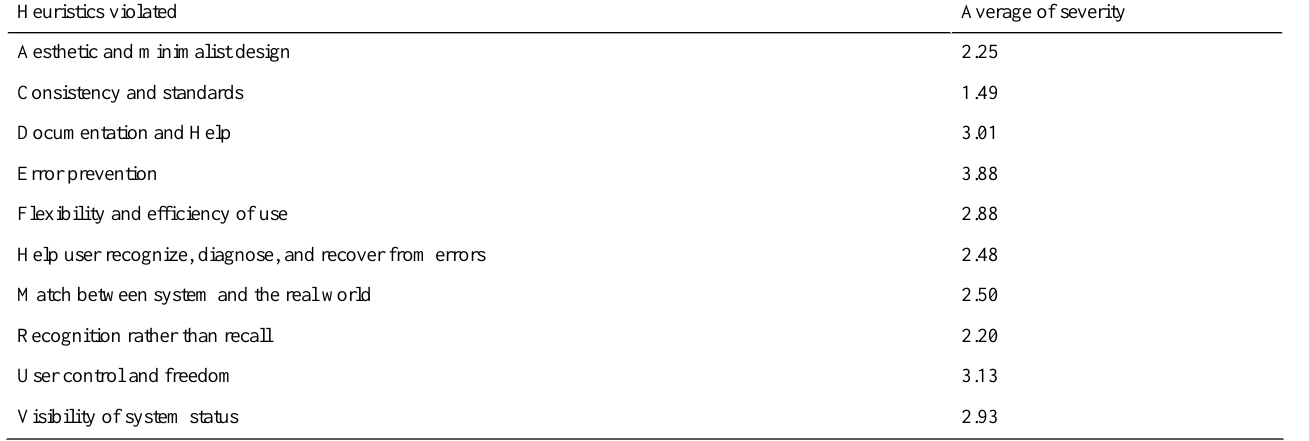
Table 3. Severity of the heuristic violations.